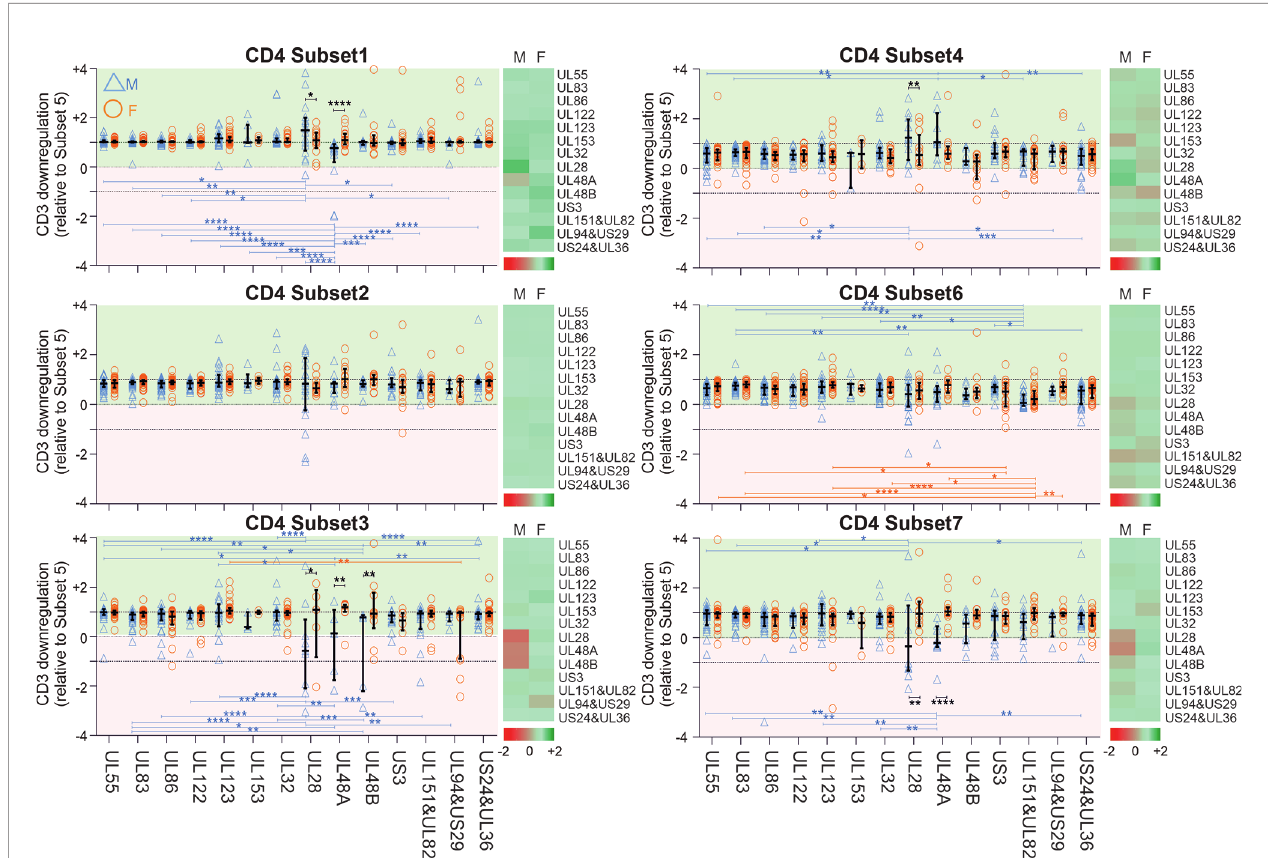
FIGURE 3 | CD3 downregulation takes place to different degrees in different functional CD4 T-cell subsets and reveals sex differences in regards to select proteins. PBMCs from men (n=47) and females (n=47) were stimulated with speci fi c CMV-protein peptide mixes and processed for intracellular cytokine staining, excluding responses below the 1/10,000 threshold. Levels of CD3 downregulation in functional subsets (Sub1 through Sub7) were standardized relative to the downregulation in Sub5. Heatmaps show CD3 downmodulation in males (M) compared with females (F). Darker shades of red represent low and darker shades of green high CD3 downmodulation. Scatter plots show CD3 downregulation in males (blue triangles) and females (orange circles). Error bars show median and interquartile range. Statistically signi fi cant differences (i) between sexes are indicated by black lines and (ii) within sexes between proteins by blue and orange lines for men and women, respectively. Statistical signi fi cance was determined by 2-way ANOVA followed by multiple end-point correction. Signi fi cance levels are * P ≤ 0.05; ** P ≤ 0.005; *** P ≤ 0.001; **** P ≤